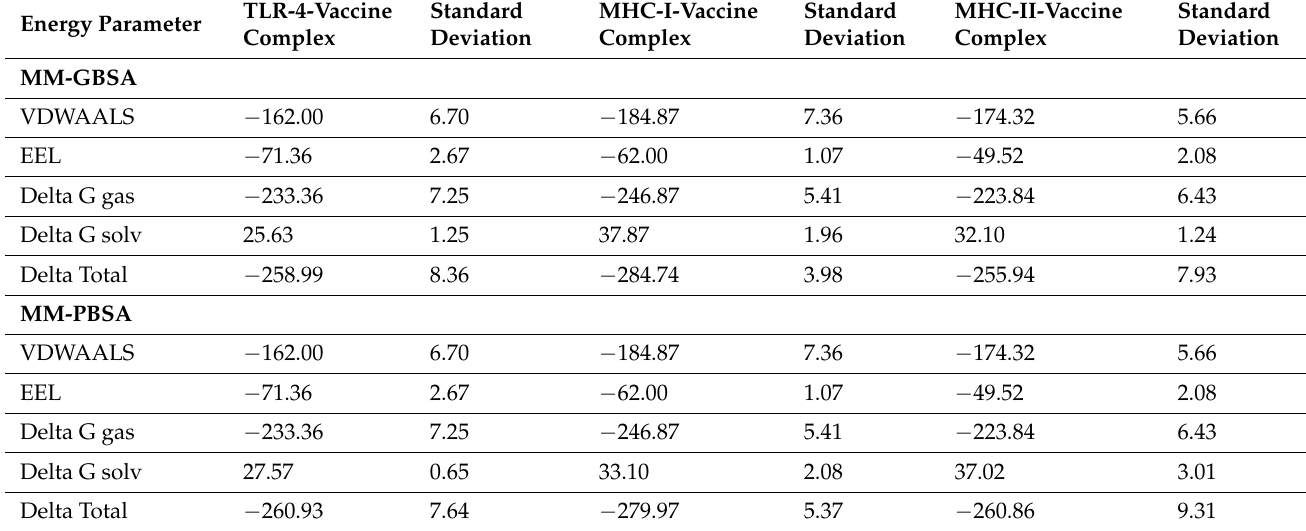
Table 4. Computed net free binding energy of Vaccine-TLR-4, Vaccine-MHC-I and Vaccine-MHC-II complexes.